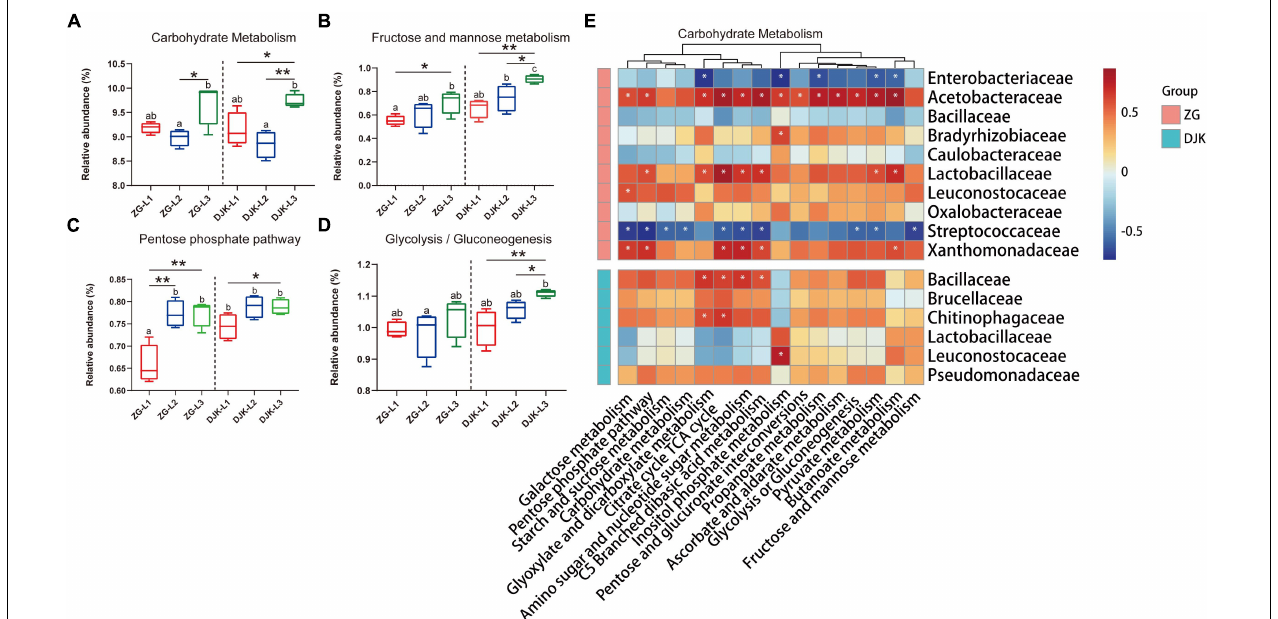
FIGURE 6 | Comparison of predicted KEGG pathways of larvae and Spearman correlation analysis. The inferred metabolic pathways are shown with carbohydrate metabolism (A) , fructose and mannose metabolism (B) , pentose phosphate pathway (C) , and glycolysis/gluconeogenesis (D) . Spearman correlation analysis between the carbohydrate metabolic pathways and bacteria (taxonomic breakdown at the family level) that vary significantly during the development of larvae is presented in heatmaps (E) . Multiple comparisons were performed with one-way analysis of variance and Tukey’s post hoc test. Different letters indicate a significant difference between different samples ( p < 0.05). ∗ p < 0.05 and ∗∗ p < 0.01, calculated by Student’s t -test. In heatmaps, blue represents negative correlation between gene expression and bacterial genus, and red represents a positive correlation, ∗ P <